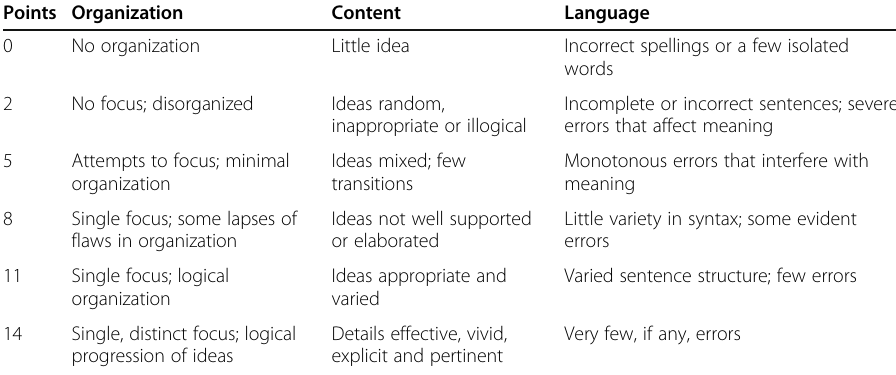
Table 8 Rating rubric for the timed online writing task (based on CET-4 writing rubric) Points